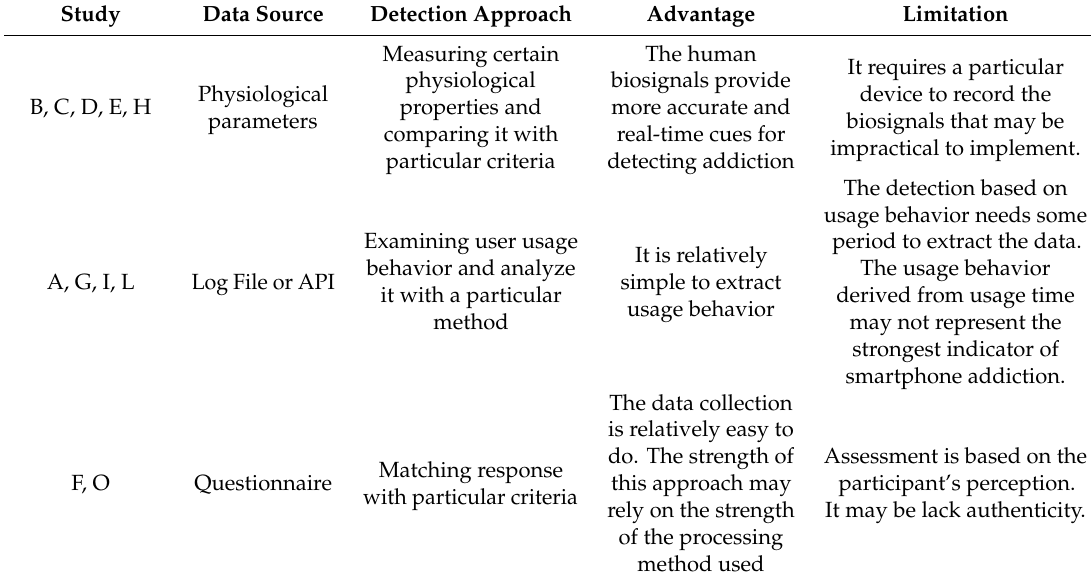
Table 3. The advantage and limitation of the detection system